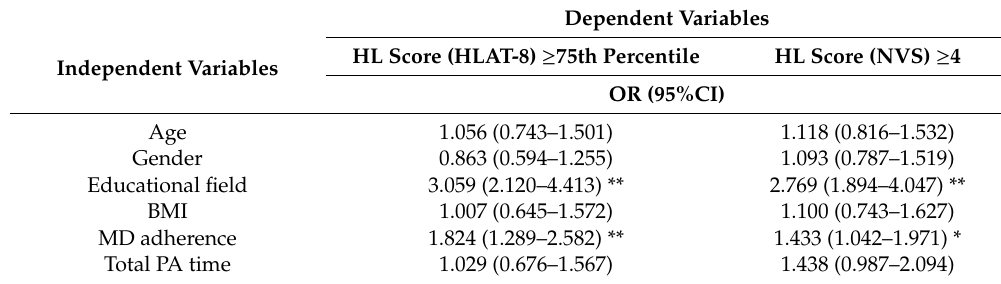
Table 3. Results of the multiple logistic regression performed on Abel and NVS HL scores as